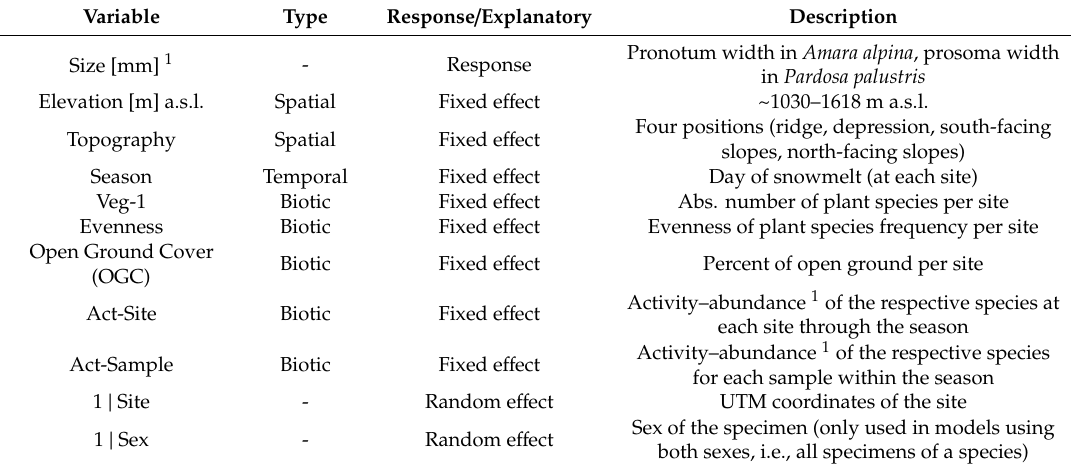
Table 1. Model parameters used in this study to explain the patterns of body sizes in the ground beetle Amara alpina and the wolf spider Pardosa palustris . Final models were selected by stepwise deletion of fixed e ff ects based on Akaike’s information criterion. Collinear variables were not included in this study.